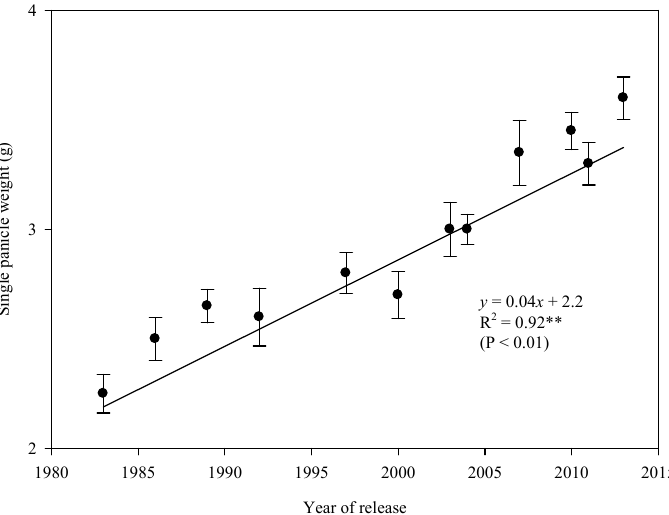
Figure 2. Relationship between year of release and single panicle weight of rice cultivars. Data were fitted by linear regression ( y = a x + b). In the linear regression, x was reassigned as years after 1983; for example, x was valued as 1 in 1983 and so on. **, significant at the 0.01 probability level according to the LSD test. Vertical bars represent ± standard error of the mean ( n = 6). The number of primary and secondary branches increased ( p < 0.01) with year of re- lease, and the annual increase in the number of secondary branches was more than that of primary branches. Similarly, the number of grains on primary and secondary branches both exhibited positive ( p < 0.01) trends to year of release; the annual increase in number of grains on secondary branches averaged 1.30 across 2 years and was higher than that of grains on primary branches (0.83) (Figure 3).